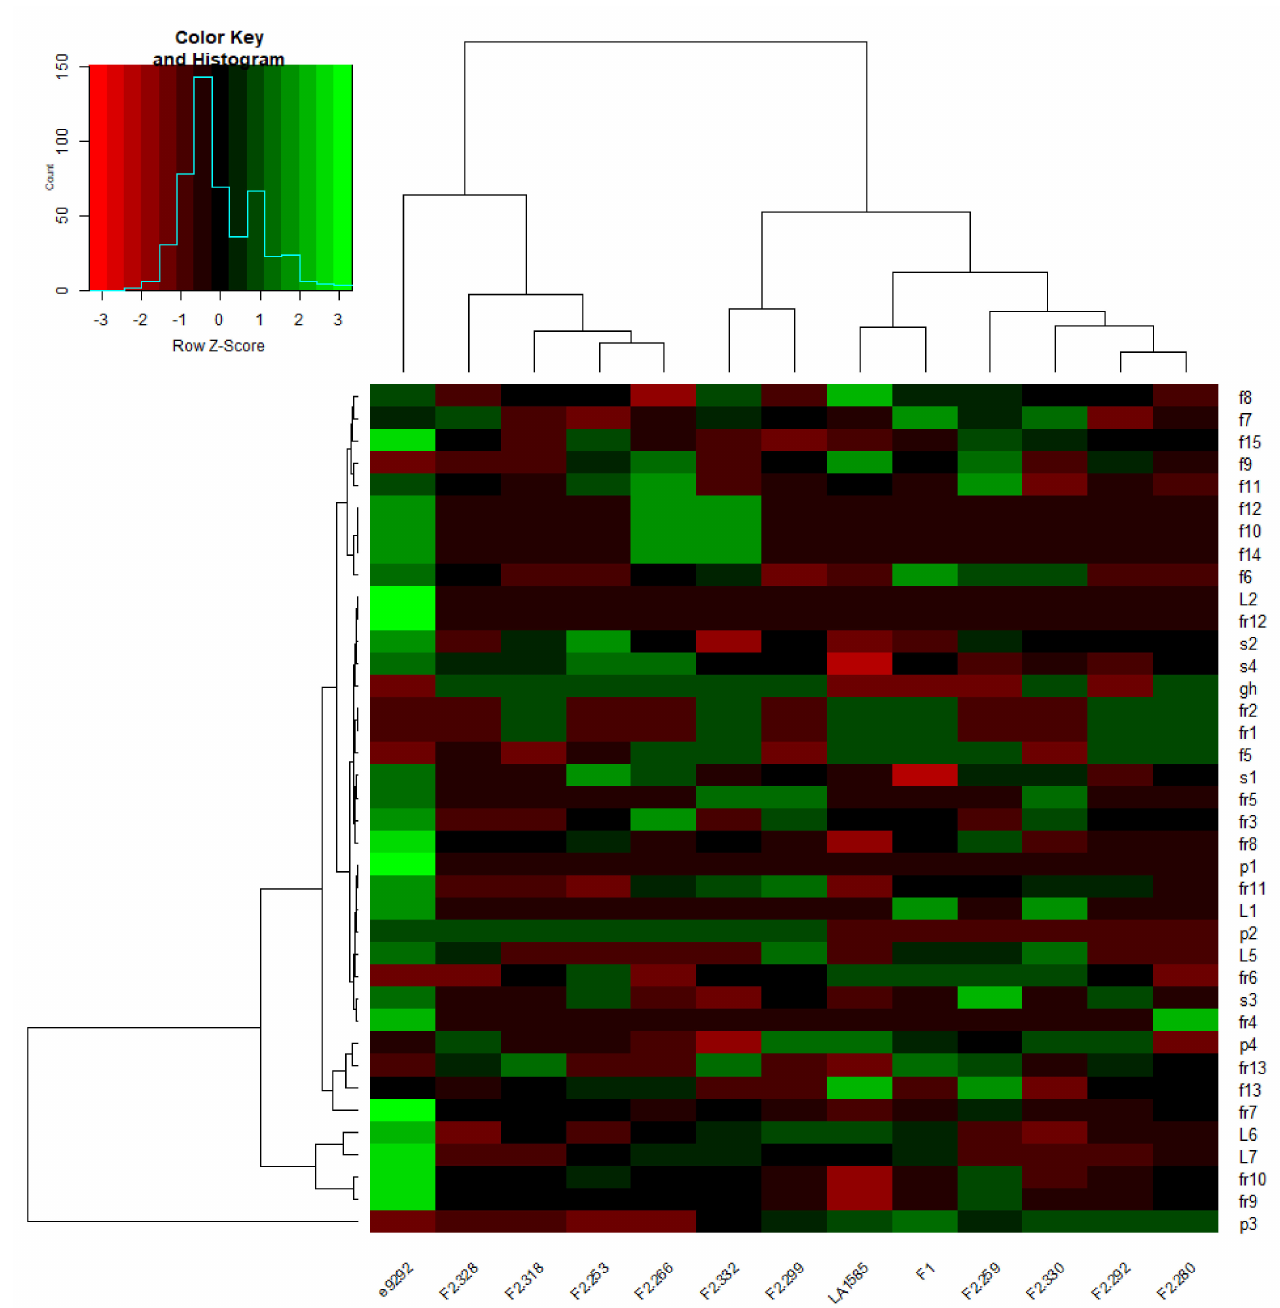
Figure 2. Heatmap visualizing data from a cluster analysis based on morphological markers from 13 tomato accessions. The different tomatoes are indicated at the bottom of the heatmap. The codes on the right side of the heatmap indicate the total of 38 polymorphic phenotype traits where differences were observed between the lines. P: plant: p1, plant type, 1-vine, 2-semi-vine, 3-straight; p2, growth type, 1-indeterminate, 2-determinate; p3, plant height (cm); p4, stem diameter (mm). L, leaves: L1, leaf shape, 1-simple odd-pinnately compound leaf, 2-bipinnate odd-pinnately compound leaf; L2, leaf attitude, 1-semi-erect, 2-horizontal, 3-drooping; L5, leaf division, 0-none, 1-lobate, 3-parted, 4-divided; L6, leaf length (cm); L7, leaf width (cm); gh, glandular hairs on the leaves or steams, 0-none, 1-thin short, 2-thick short, 3-thin long, 4-thick long. F: flower: f5, style type, 1-shorter than the stamen, 2-nearly the same length as the stamen, 3-longer than the stamen; f6, number of leaves under the